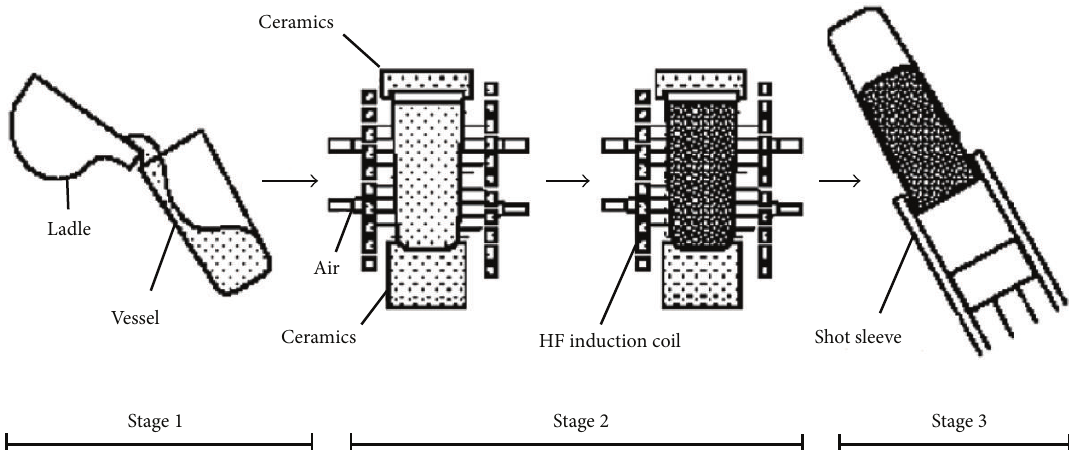
Figure 12: Schematic illustration of the stages of New Rheocasting (NRC)